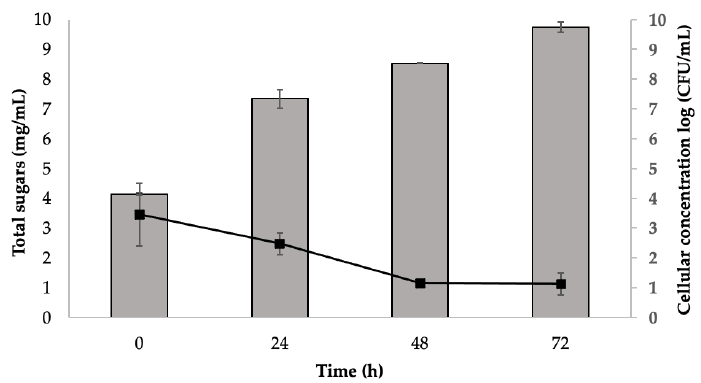
Figure 2. Total sugar content ( ■ ) (mg/mL, average ± SD) and S. cerevisiae growth ( ■ ) (Log cycles, average ± SD) measured in cell broth along 72 h fermentation process of sugarcane straw that went through saccharification.